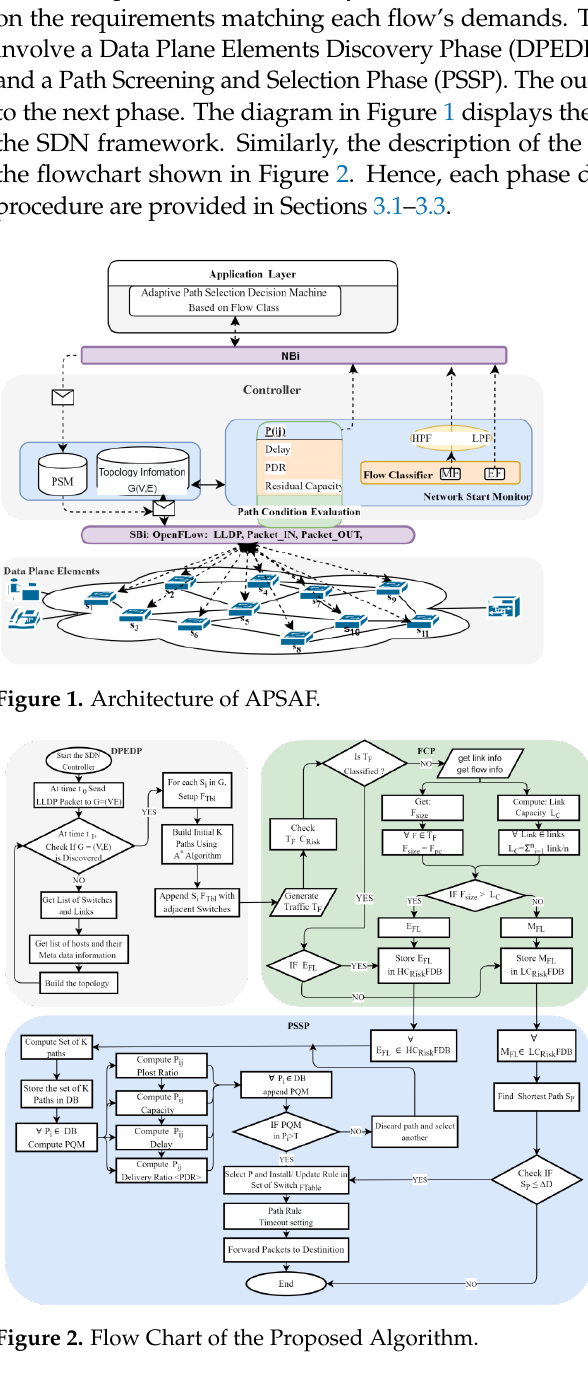
Figure 2. Flow Chart of the Proposed Algorithm. 3.1. Data Plane Elements Discovery Phase (DPEDP) The Data Plane (DP) elements represent the network topology, which consists of a collection of hosts 𝐻 = { ℎ 1 , ℎ 2, ℎ 3 … . . ℎ |𝐻| } and switches 𝑉 = { 𝑠 1 , 𝑠 2, 𝑠 3 … . . 𝑠 |𝑉| } . Their to- pology is modeled as a graph 𝐺 = (𝑉 ∪ 𝐻, 𝐸) where 𝐸 is a set of links 𝐸 = { 𝑒 1 , 𝑒 2, 𝑒 3 … . . 𝑒 |𝐸| } connecting any two switches 𝑠 𝑖𝑗 . Each of these links 𝑒 𝑖,𝑗 ∈ 𝐸 has a ca- pacity 𝐶(𝑒 𝑖,𝑗 ) and is responsible for carrying traffic flow 𝑇 𝑓 from a source switch 𝑠 𝑖 to destination switch 𝑠 𝑗 . These elements are discovered and built into a topology using the procedure described in DPED of Figure 2 and Algorithm 1. When topology discovery sta- tus 𝑇𝐷𝑡 𝑥 = 0 , the SDN controller initiates a Link-Layer Discovery Protocol (LLDP) to dis- cover the network elements ’ presence at the DP. Beginning with the initial handshake, the